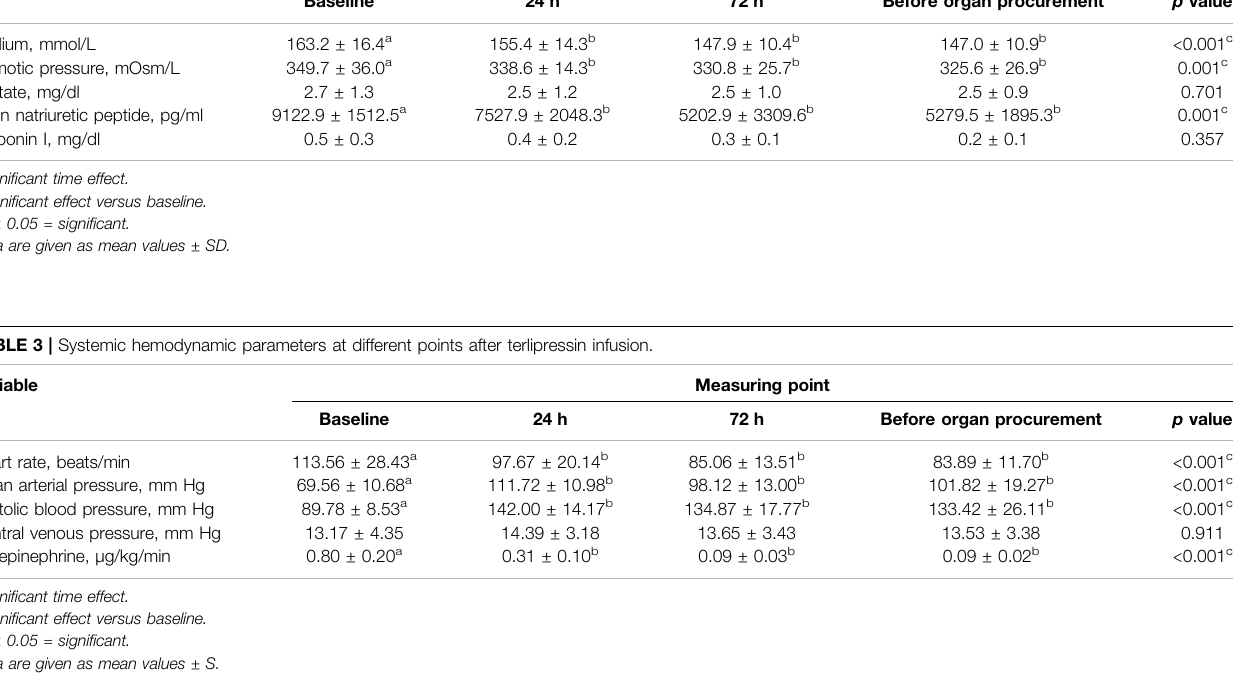
TABLE 2 | Biochemical indexes at different points after terlipressin administration. Variable